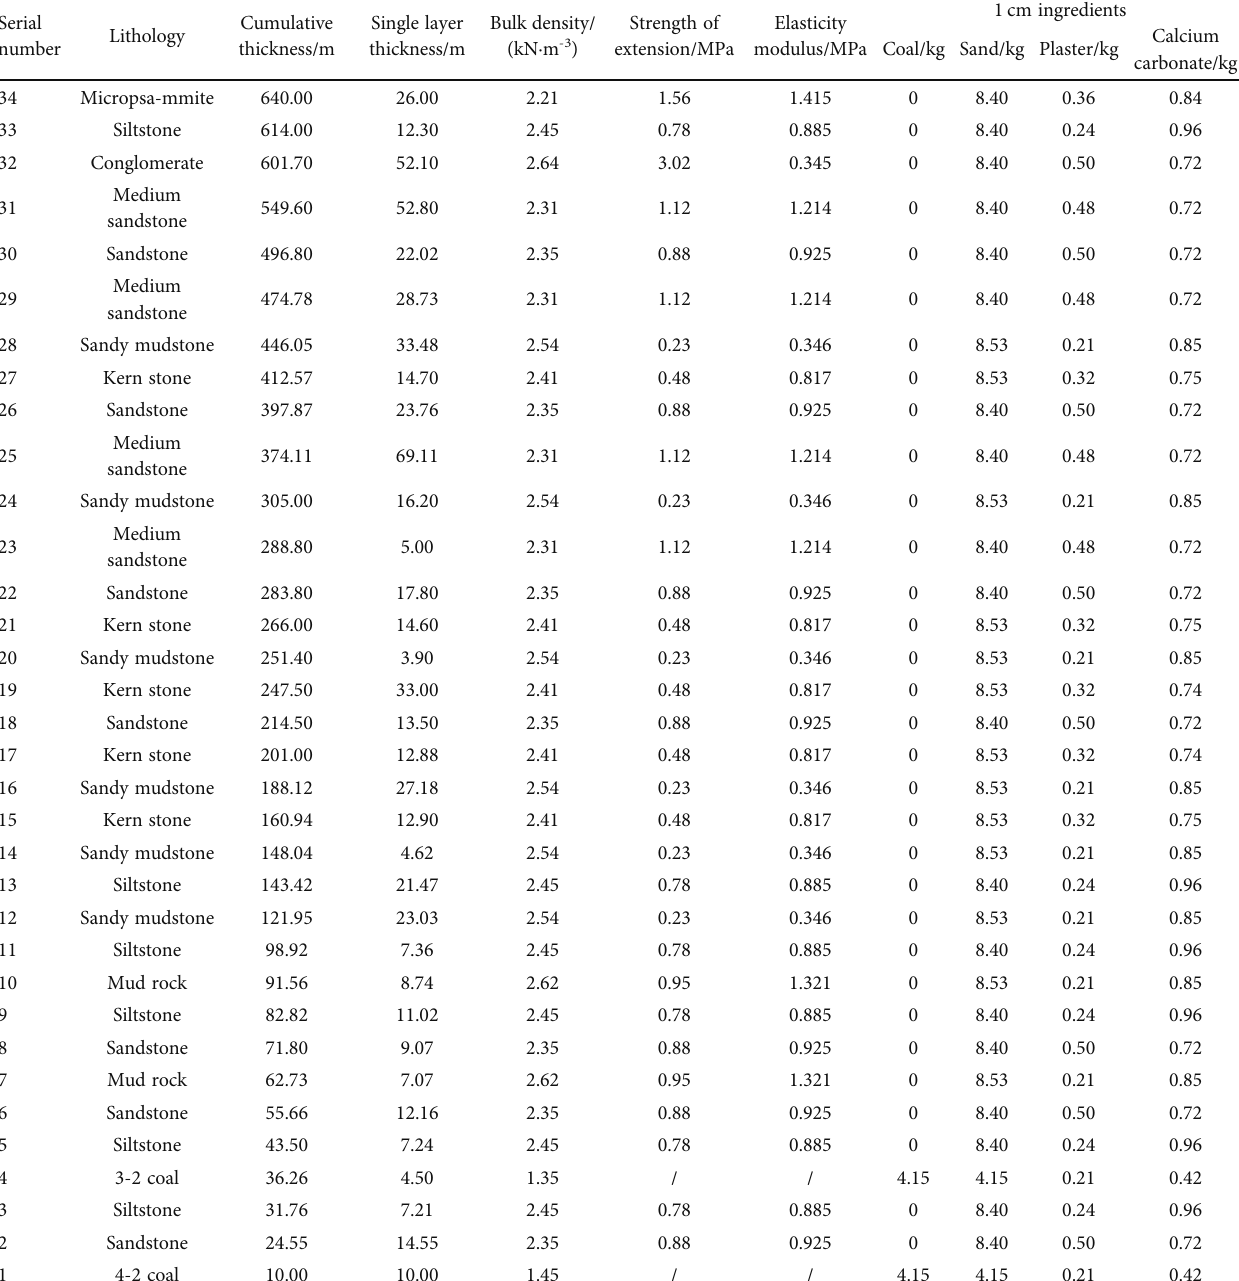
Table 1: Mechanical parameter of coal and rock and ratio of physical similarity simulation